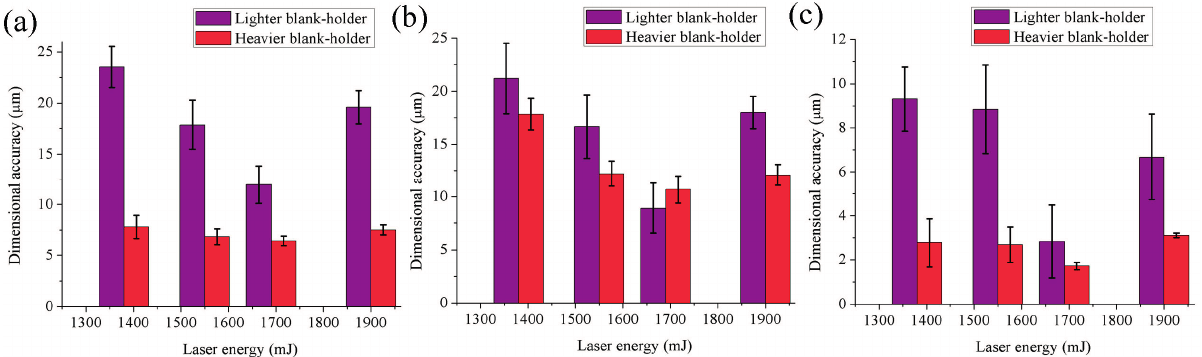
Figure 9. Comparision of dimensional accuracy with different blank-holders: ( a ) addendum circle; ( b ) dedendum circle; and ( c ) hole. Error bar: Standard deviation.